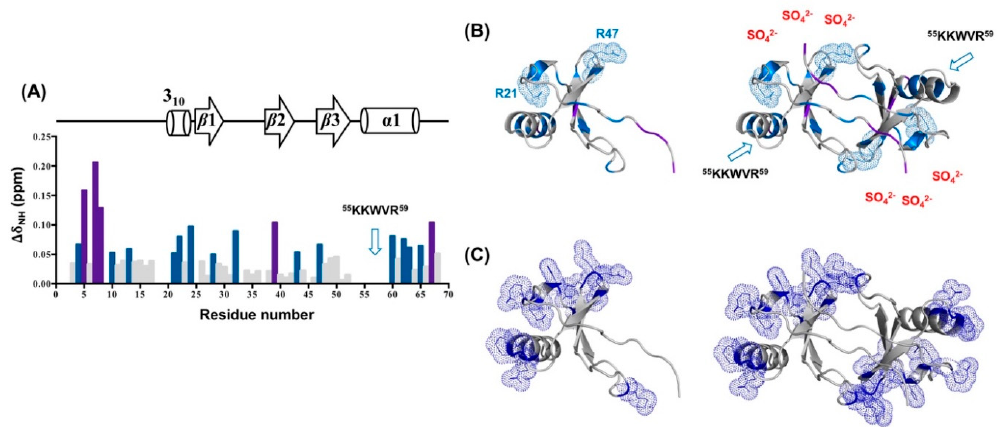
Figure 8. Sulfate-induced perturbations on the CCL5- 12 AAA 14 dimer. ( A ) Chemical shift perturbations of CCL5- 12 AAA 14 induced by 180 mM ammonium sulfate. Residues with perturbation >0.05 ppm are colored by blue and >0.1 ppm by purple. ( B ) The perturbated residues are mapped on the monomer unit and dimer structure of CCL5- 12 AAA 14 . Two perturbed basic residues, R21 and R47, and